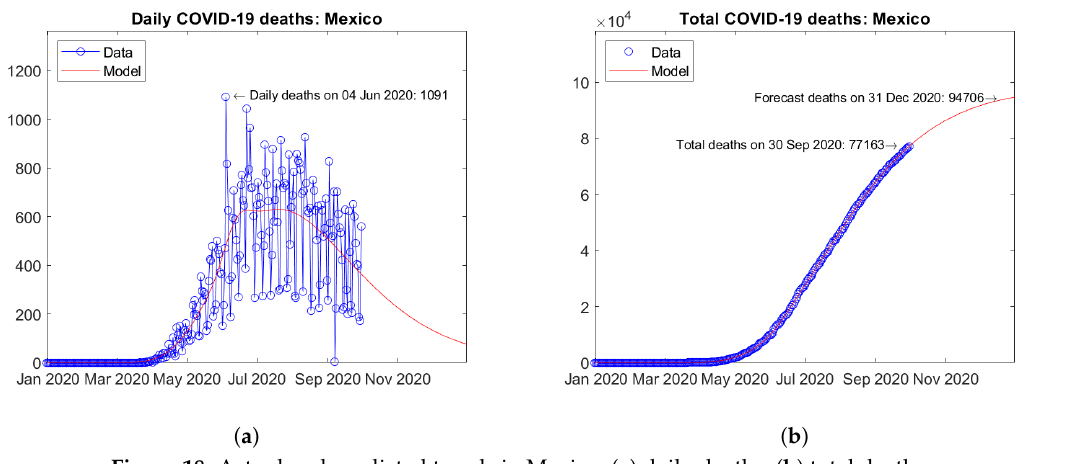
Figure 18. Actual and predicted trends in Mexico: ( a ) daily deaths, ( b ) total